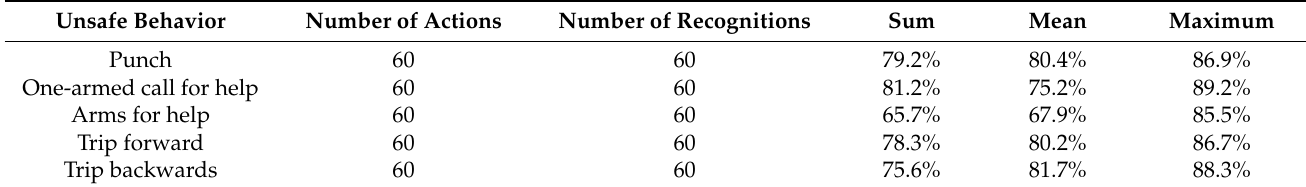
Table 10. Local “pelvis divergence method” identification results.